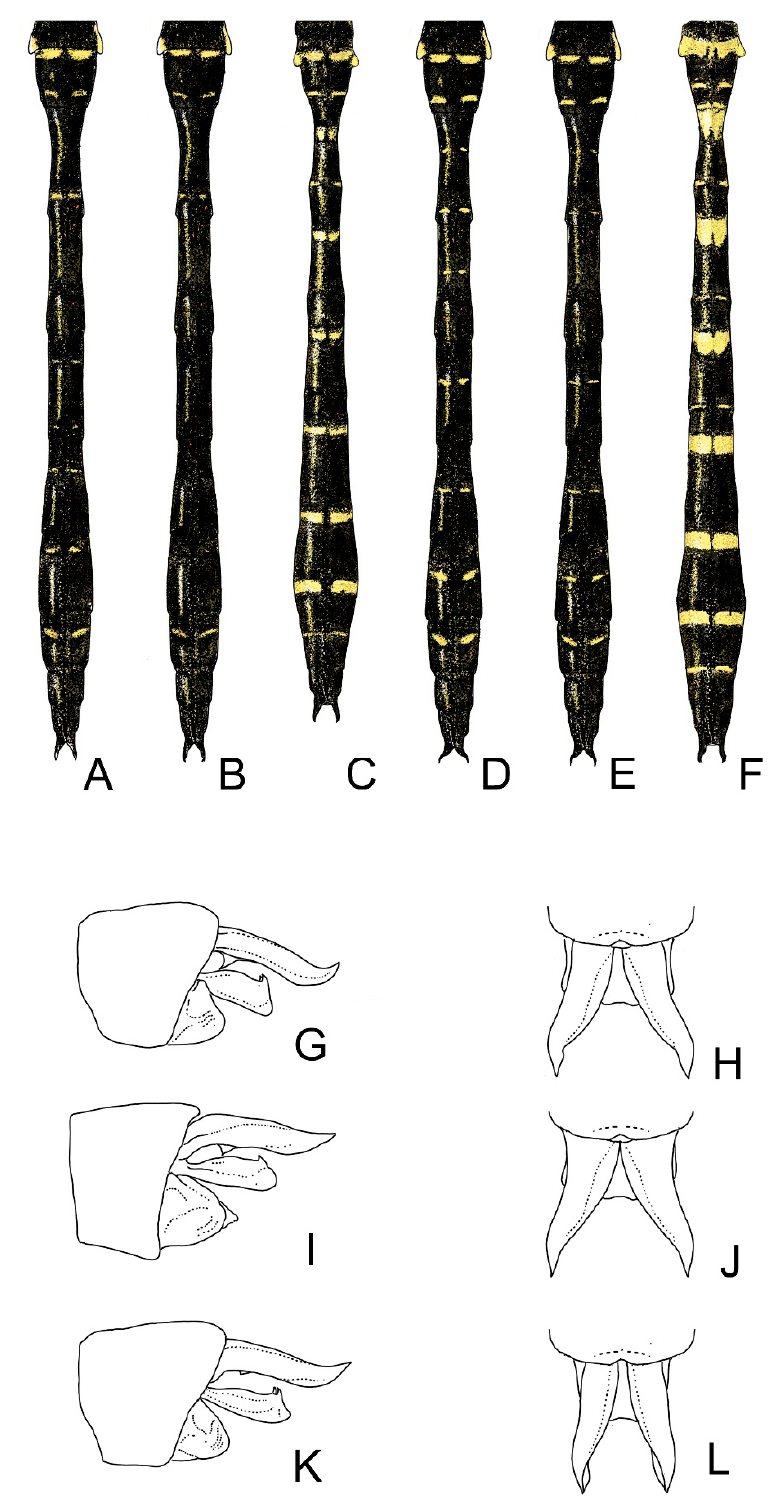
Figure 8. Abdominal variation of C. vanbrinkae : ( A ): Golestan, Iran. ( B ): Mazandaran, Iran. ( C ): Golestan. ( D ): Armenia, possible hybrid: C. picta × C. vanbrinkae not genetically analyzed. ( E ): Armenia, hybrid: C. picta × C. vanbrinkae genetically analyzed. ( F ): C. picta Georgia. ( G , H ): lateral and dorsal view of the male appendices from C. picta Georgia. ( I , J ): Hybrid C. picta × C. vanbrinkae , Armenia. ( K , L ): C. vanbrinkae , Mazandaran.